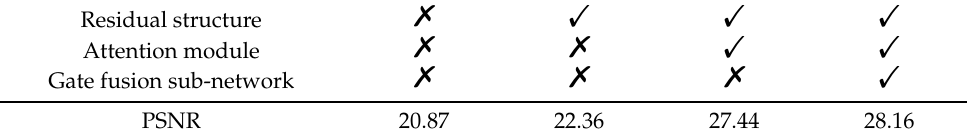
Table 4. Ablation analysis for each component with different training configurations. Residual